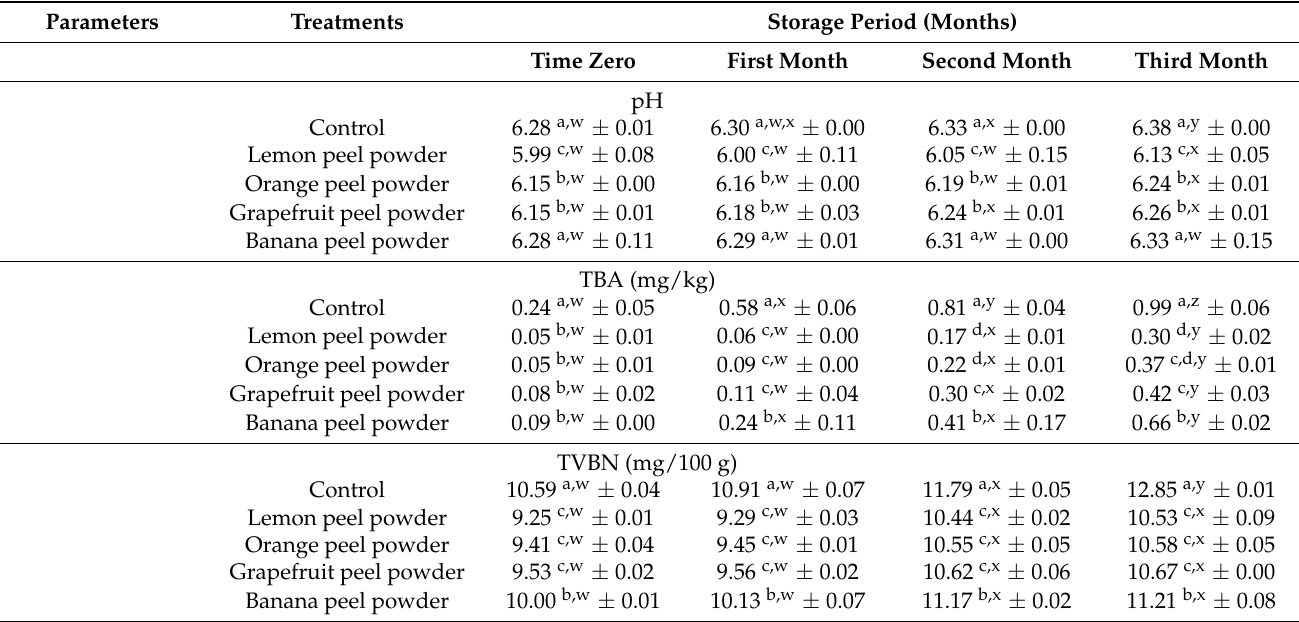
Table 3. Deterioration criteria of chicken patties with the incorporation of different fruit peel powders (1%) during frozen storage ( − 18 ◦ C) for 3